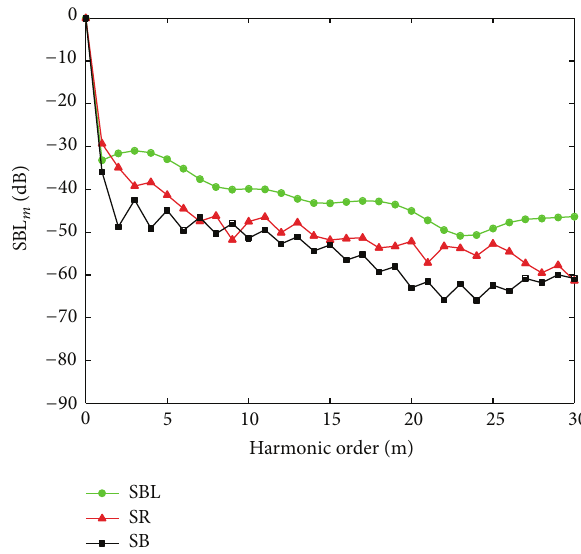
Figure 21: The first 30 maximum harmonic levels of best converged solution related to Figure 19 for JSCIS.